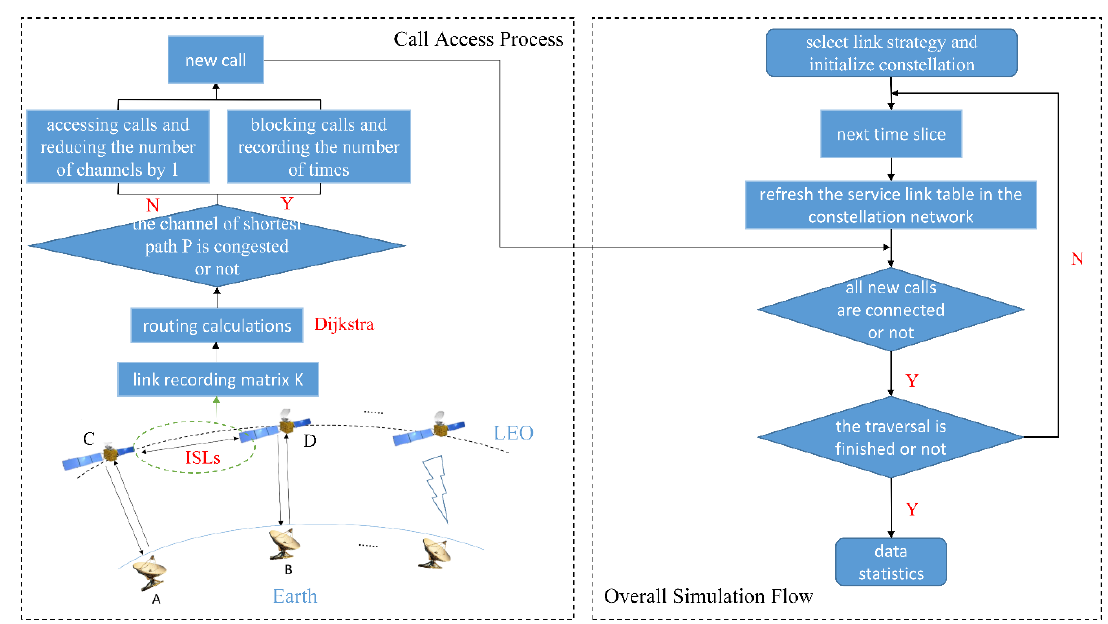
Figure 4. General flow of the simulation.